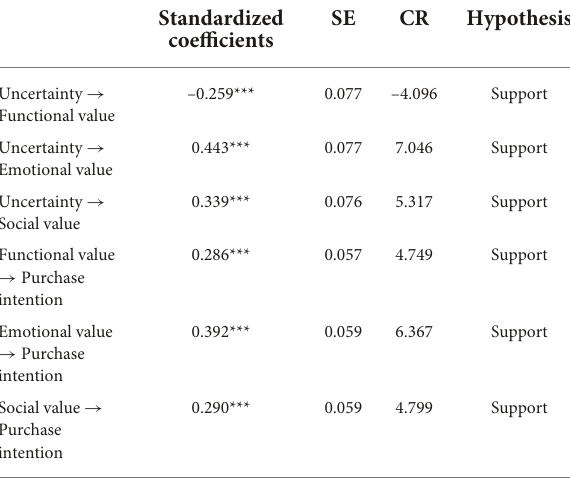
TABLE 4 Path test of the